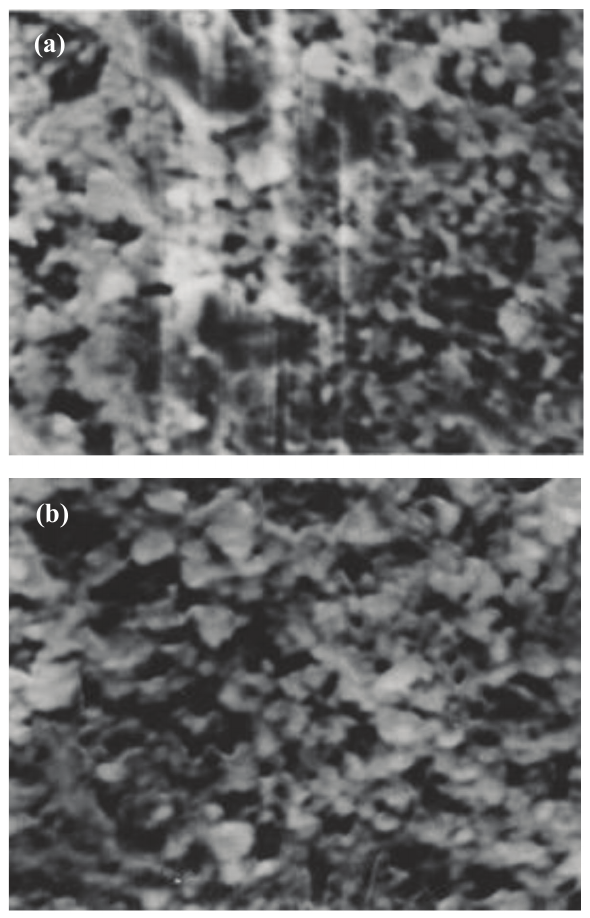
Fig. 6 – SEM images of different catalysts: a) 2 % Pt-Rh (9:1)/Al